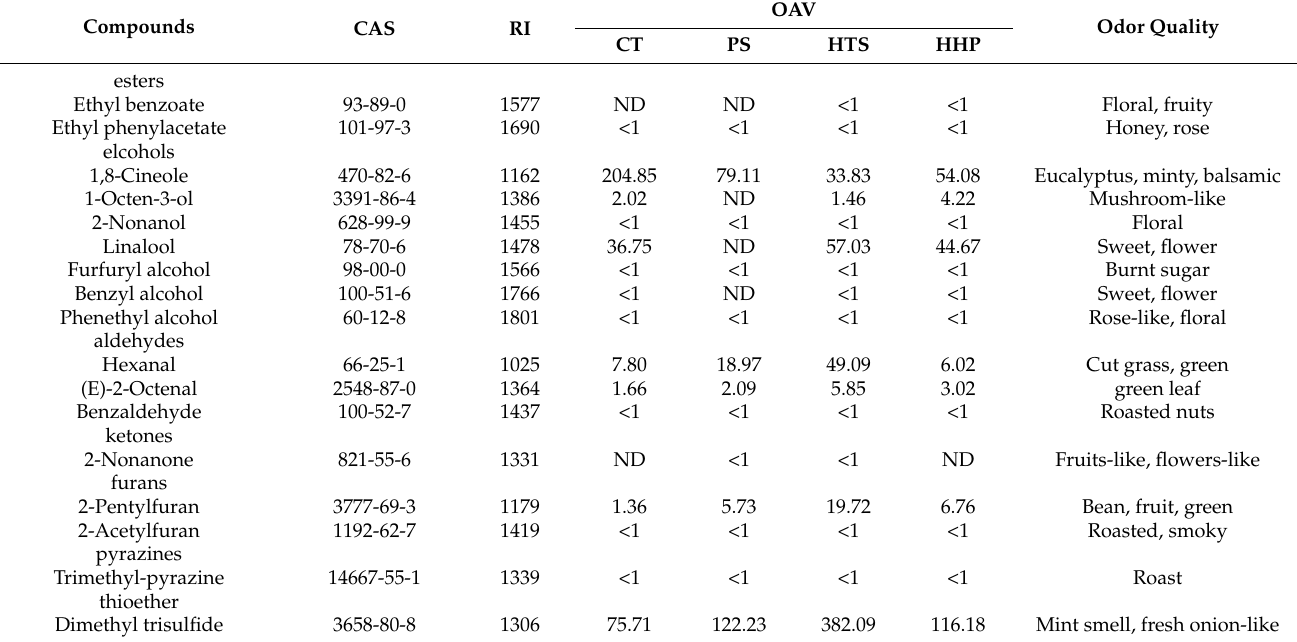
Table 2. Odor activity value of the aroma compounds in